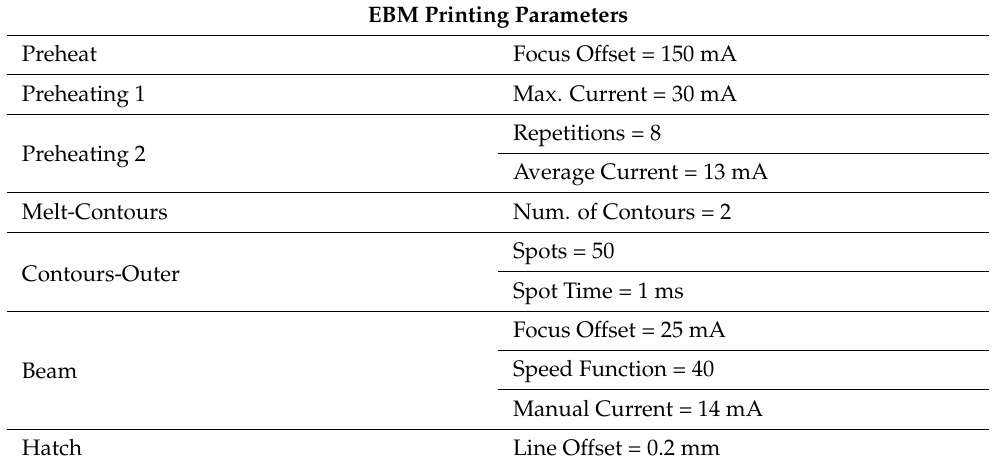
Table 2. EBM printing